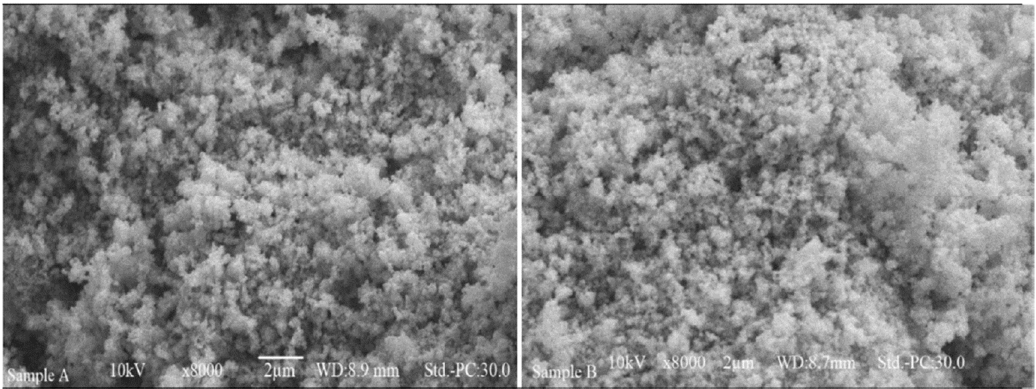
Figure 2. SEM images of sample A and sample B. Reprinted/adapted with permission from Ref. [56]. Copyright © 2022, Elsevier GmbH.